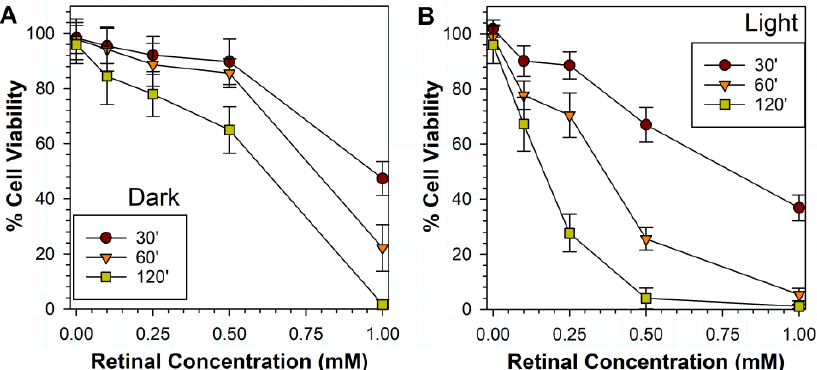
Figure 2. Phototoxicity to ARPE-19 cells of liposomes with different concentrations of ATR in the dark ( A ) and after exposure to visible light ( B ). The incubation times (in minutes) in the dark and during exposure to visible light are indicated in the figure legends. Cell viability was measured by MTT assay 24 h after the exposure. The symbols indicate the means, while the error bars indicate SDs.